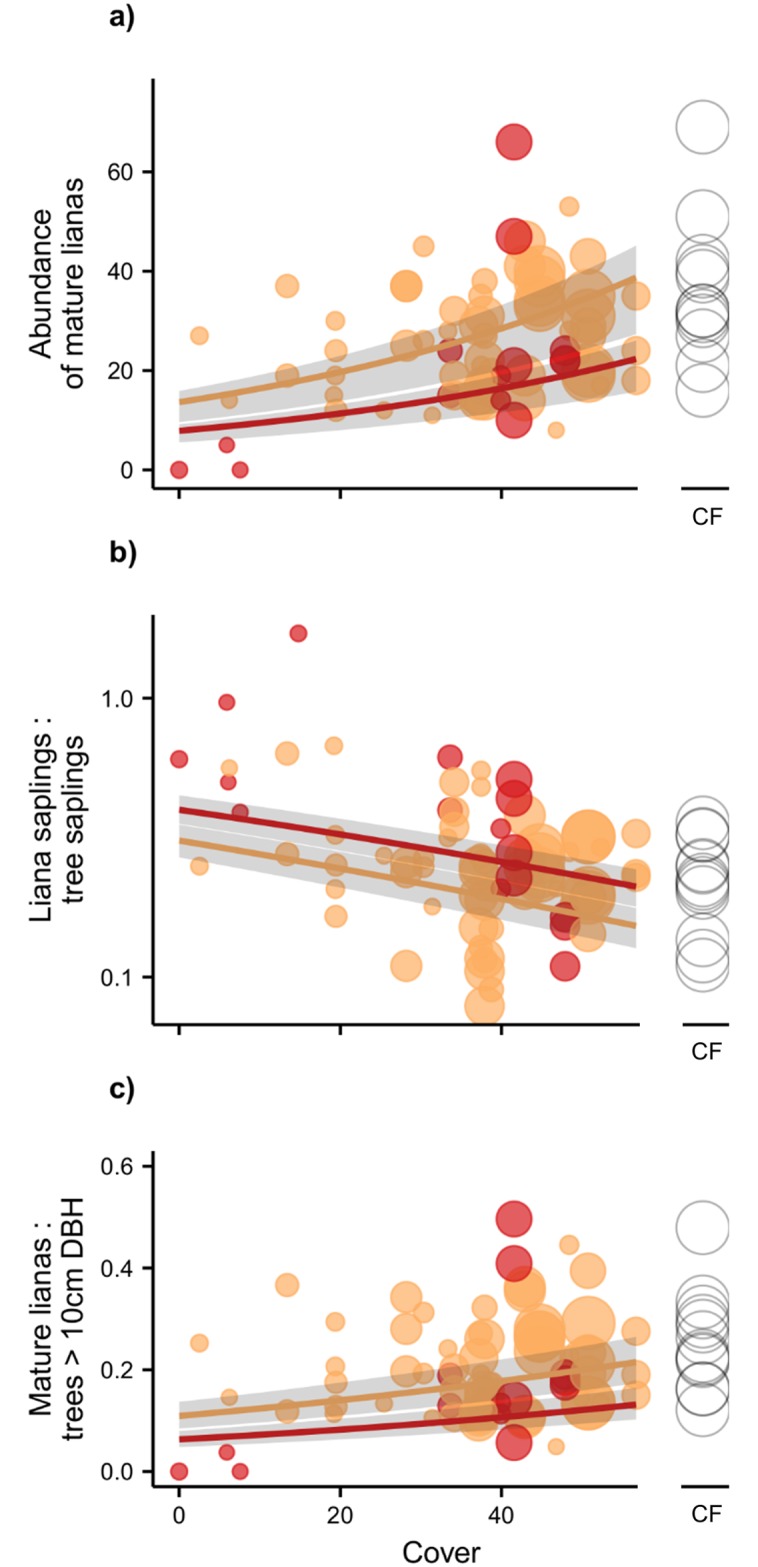
Abundance and relative dominance of lianas.The (a) abundance, (b) relative dominance of liana saplings to tree saplings, and (c) relative dominance of mature lianas to trees ≥10 cm DBH, as a function of the amount of neighbouring forest cover. Plot-level data are plotted as circles, scaled in size by island area. In each case a binary Fire variable was used, where low-moderate burn severity (scores 1 and 2; orange circles) were collapsed into a single level and compared to severe burning (score 3; red circles). Lines are predicted values, with grey shading indicating 95% confidence intervals. Data for mainland continuous forest plots (CF; open circles) were not included in model fits but are shown here for comparison.